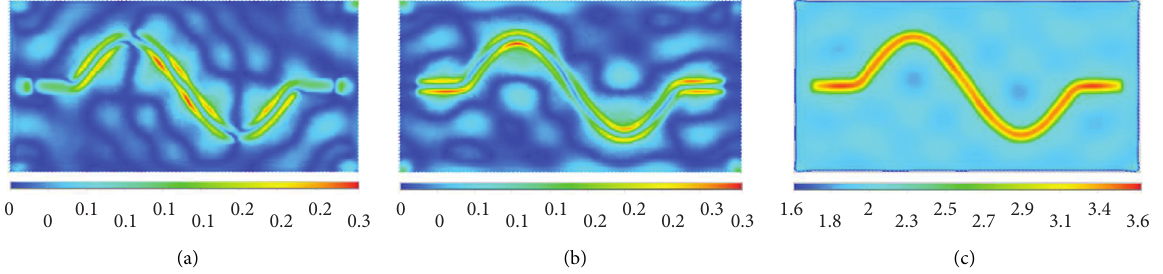
u u x , (b) y , and (c) z .